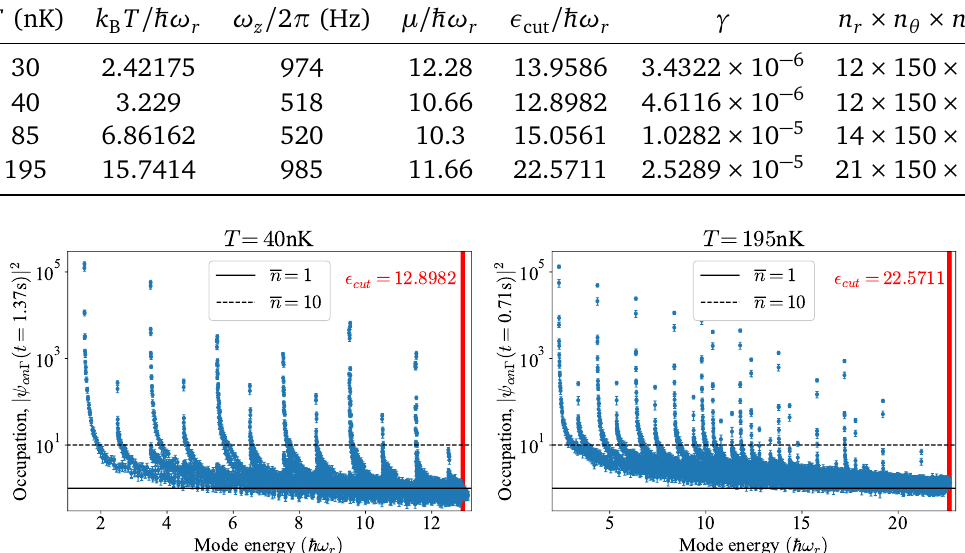
Figure 11: Mean occupation of single-particle modes of the C region as a function of mode energy. The occupation is shown at a time part-way through the simulation to ensure some decay events have occurred, for system parameters: (left) T = 40nK /µ = 0.78, and (right) T = 195nK and V and V b high-energy modes near the cutoff are on the order of n ≈